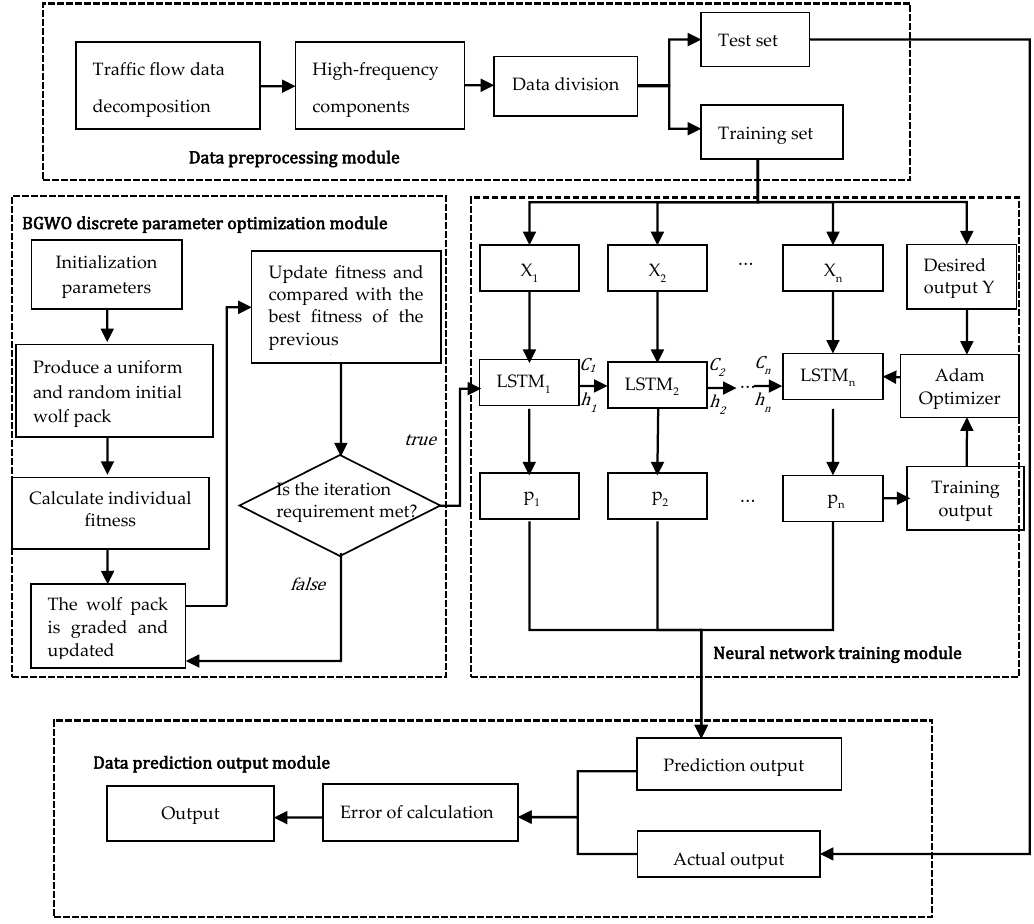
Figure 1. High-frequency component prediction flowchart based on BGWO-LSTM.